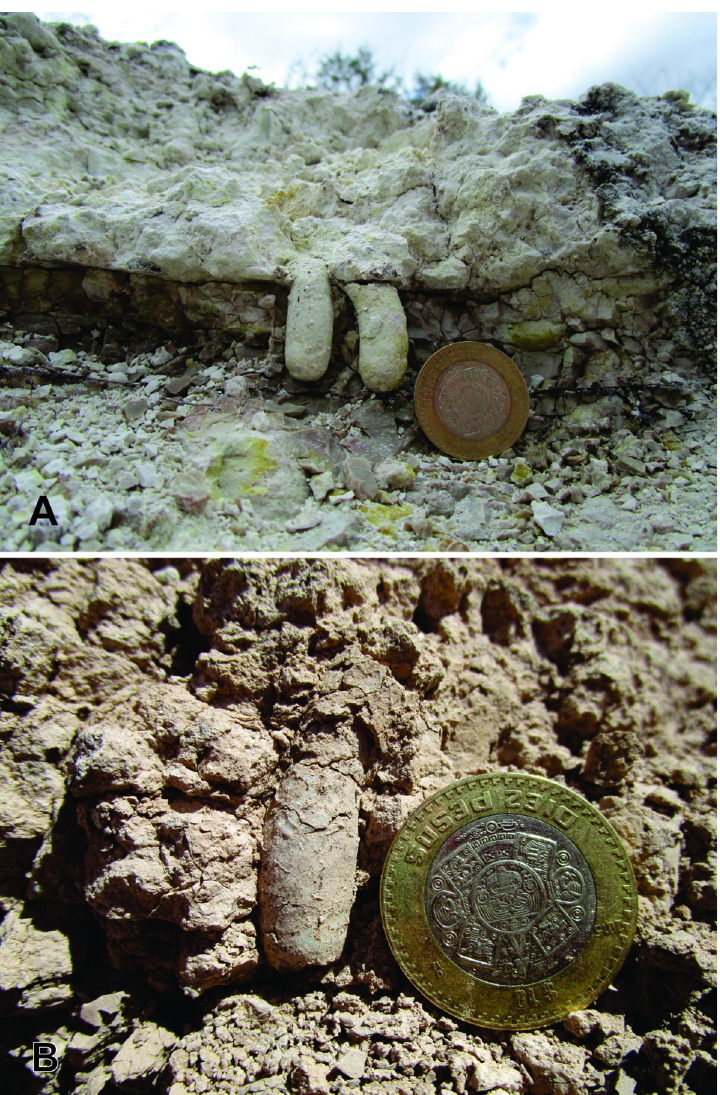
Fig 11. Insect trace fossils found in the same stratigraphic levels as Y . iniyooensis . (A) Specimen of Cellicalichnus ? isp. from the “lower beds”; (B) Celliforma isp. from the “middle beds”. Diameter of the coin in both figures = 28